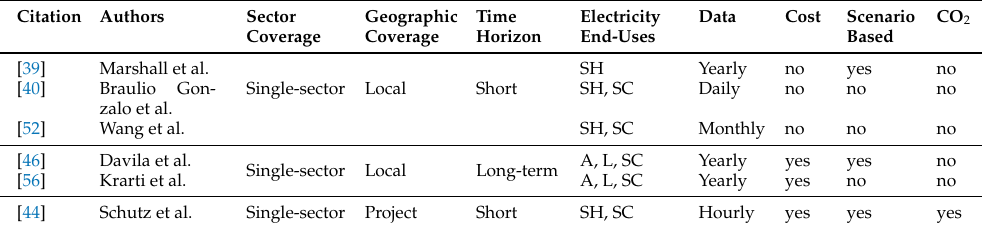
Table 9. Characteristics of bottom-up energy models—Residential Buildings.